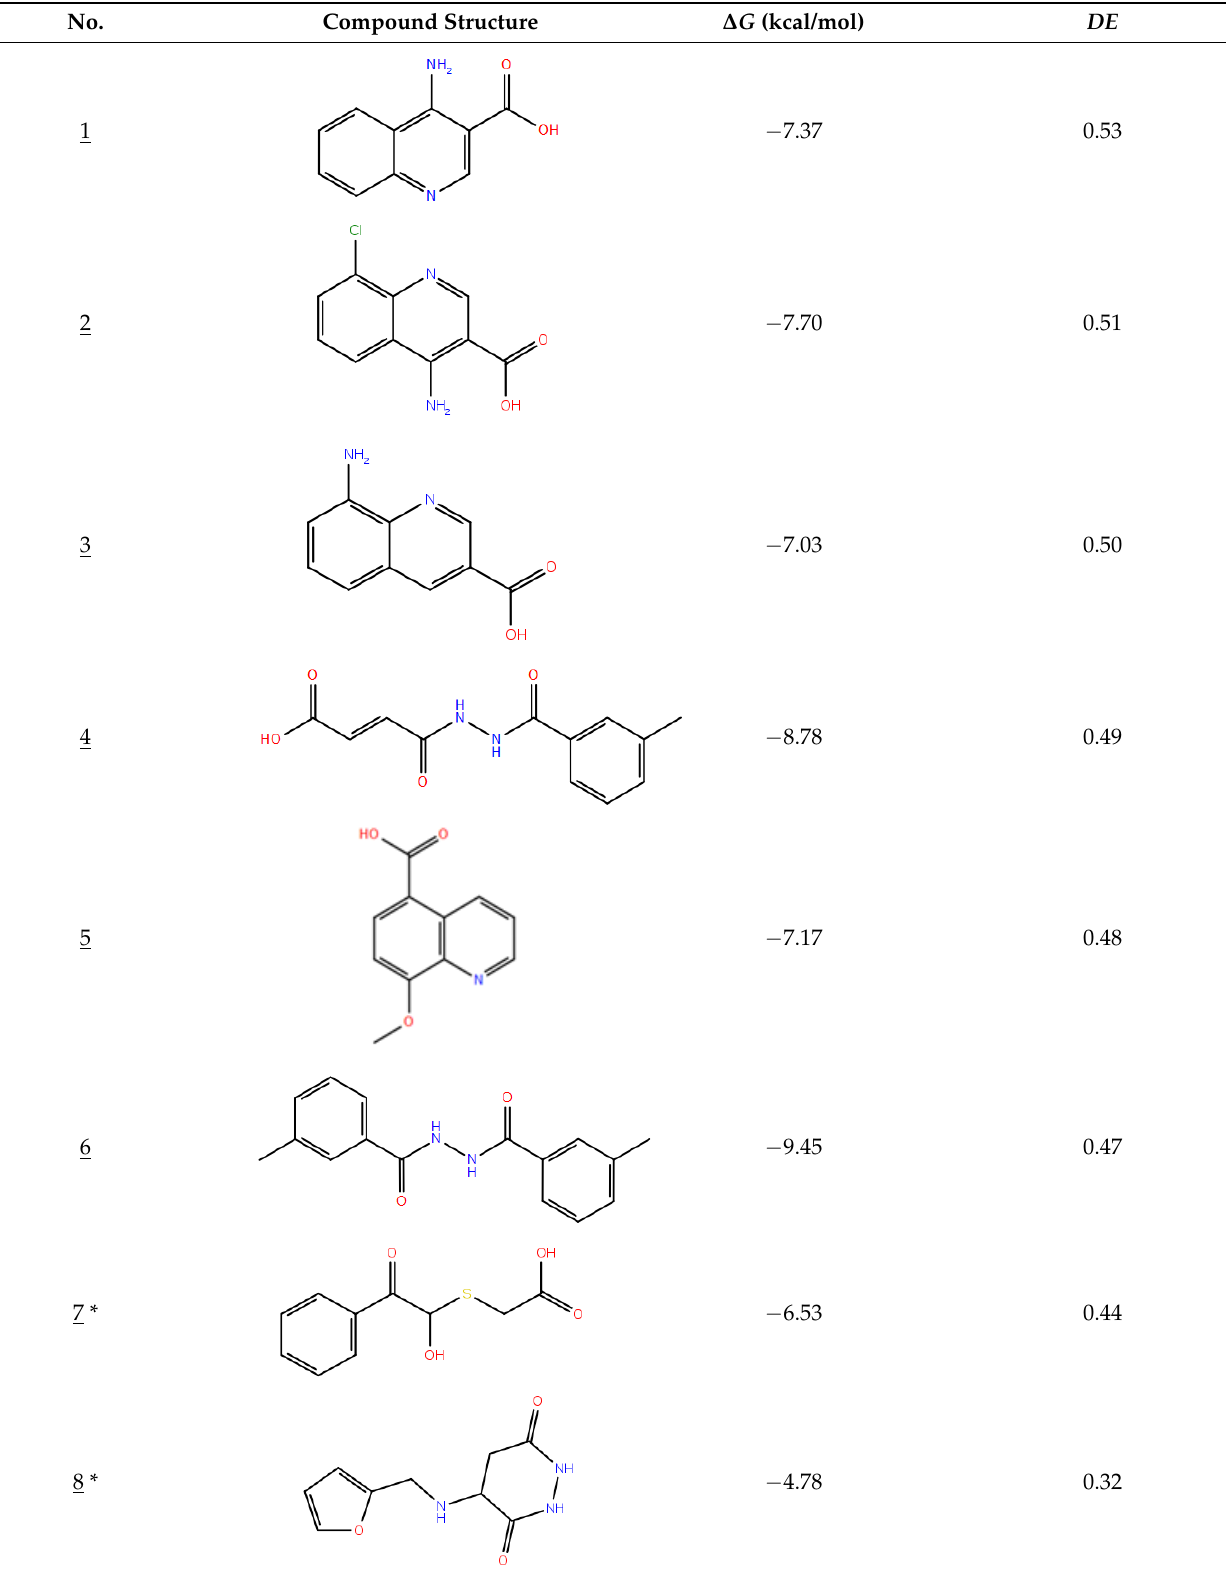
Table 1. Compounds with the highest docking efficiencies DE to FTO protein. No.